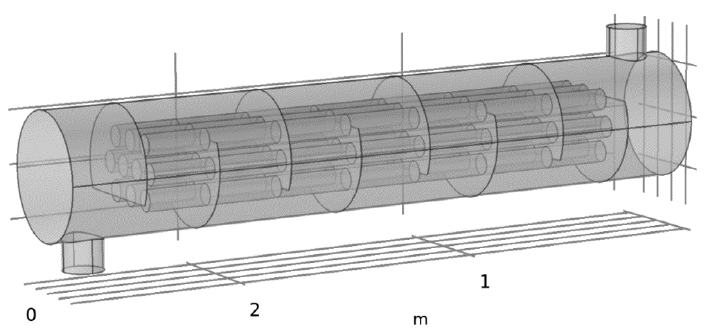
Figure 4. Model 2. Figure 4. Model 2.